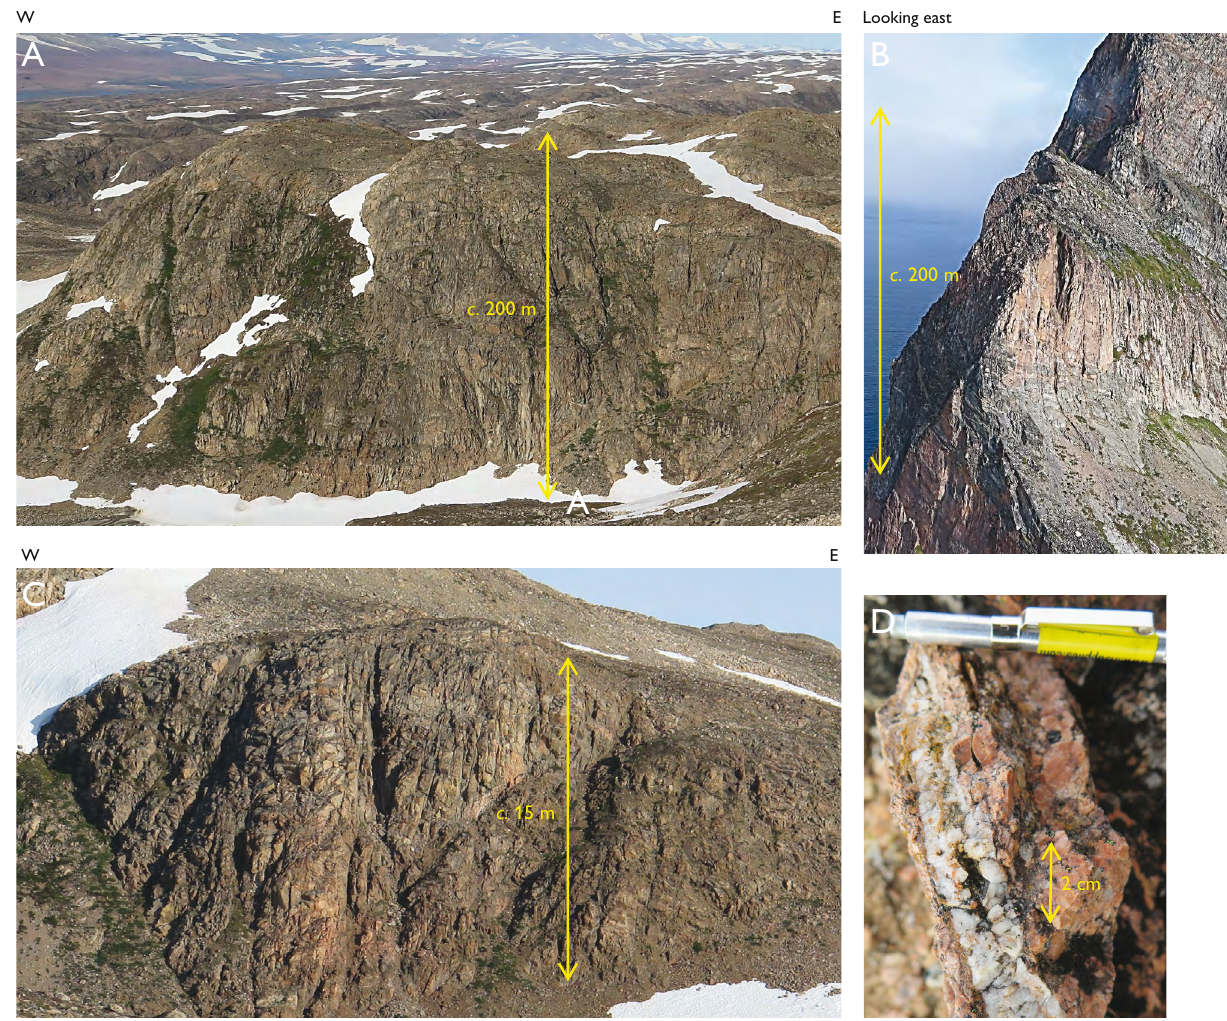
Fig. 5. Reconnaissance of the LLBH. A : Exposure of top basement morphology and 3D fracture network connectivity. B : Pervasive fractures > 200 m high on Janus Ø. C : Intense fracturing of basement matrix at the scale of one reservoir model grid cell ( sub- kilometre scale). D : Partly-cemented vein aperture at core-plug scale